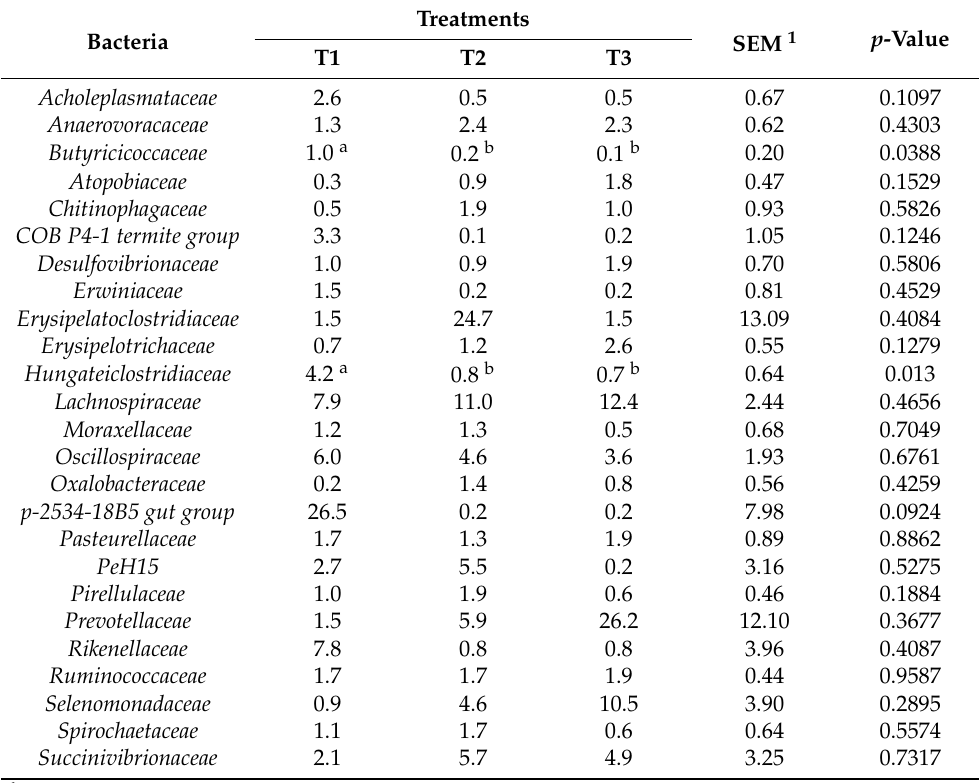
Table 3. Effects of sprouts supplementation on bacterial abundance at family level on meat-master lambs (>1% at least in one